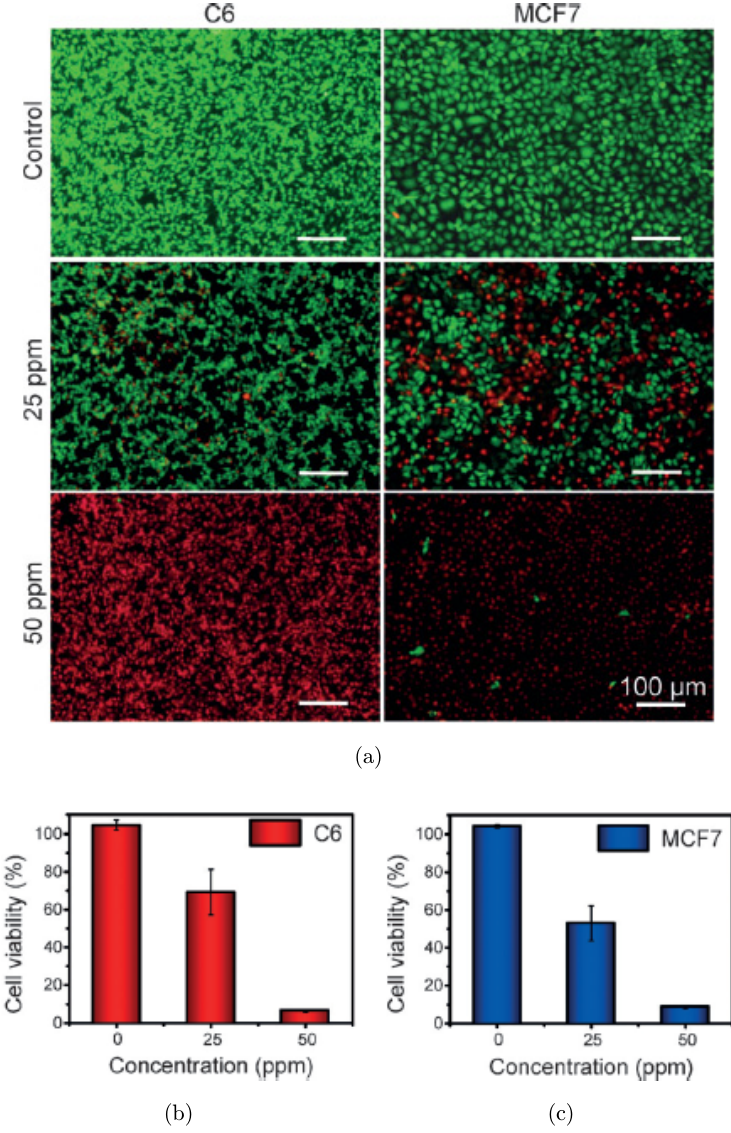
Fig. 3. The dependence of cell viability on concentration of BPQDs and cell lines. The irradiation time is 10 min and power density of 808 nm laser is 1.0 W cm (cid:2) 2 . (a) Fluorescence images of cancer cells incubated with BPQDs after irradiation of 808 nm laser. (b) C6 cells viability after treatments with di®erent concentrations of BPQDs. (c) MCF7 cells viability after treatments with di®erent concentrations of